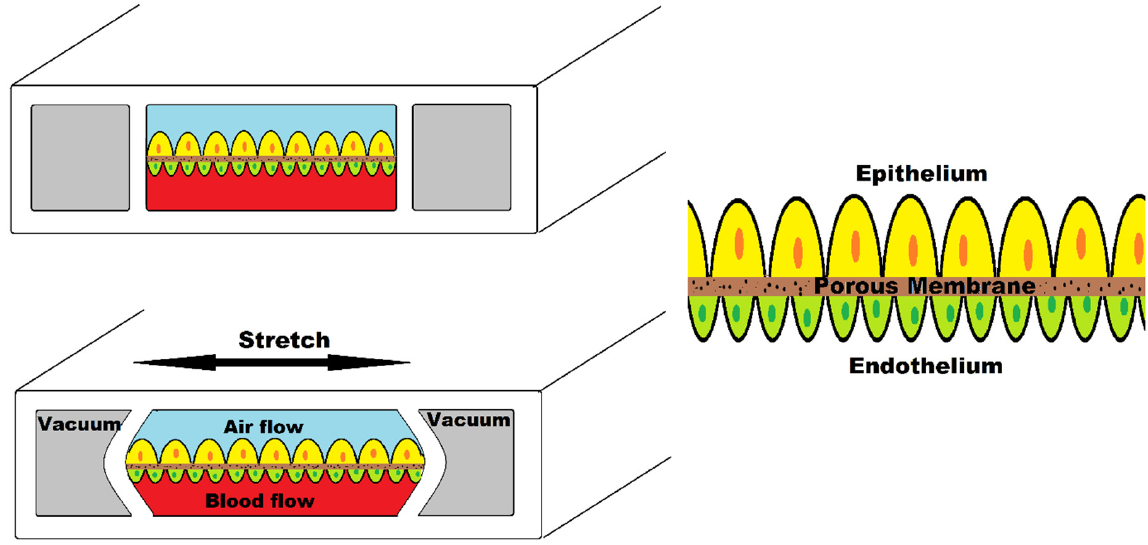
Figure 9. Human lung-on-a-chip device.